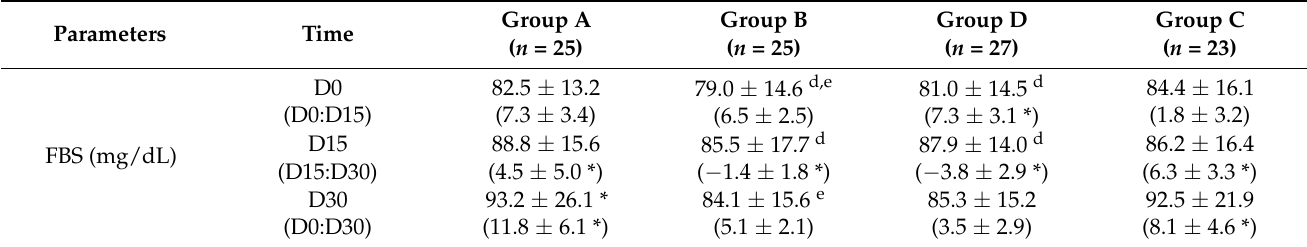
Table 3. Levels of serum glucose and lipid profiles of elderly subjects. Non-anemic elders consumed the WR drink (2 mg iron/100 mL serving) (group A), IR drink (15 mg iron/100 mL serving) (group B) and IR drink (27 mg iron/100 mL serving) (group D), and anemic elders consumed the IR drink (15 mg iron/100 mL serving) (group C) for 30 days and blood samples were collected for analysis of glucose and lipids. Data are expressed as mean ± SD values. Changes in the mean are shown as mean ± SD values in the